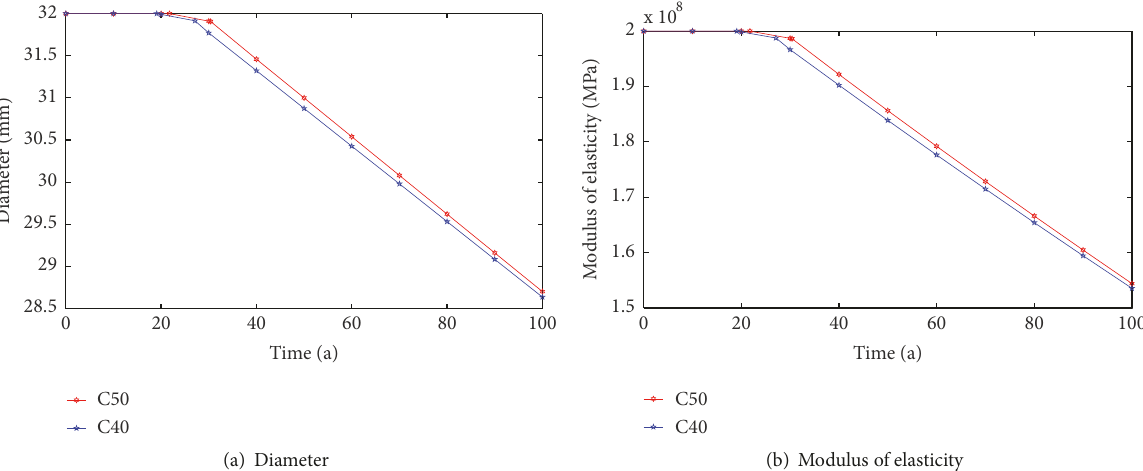
Figure 9: Mechanical properties of longitudinal reinforcement.